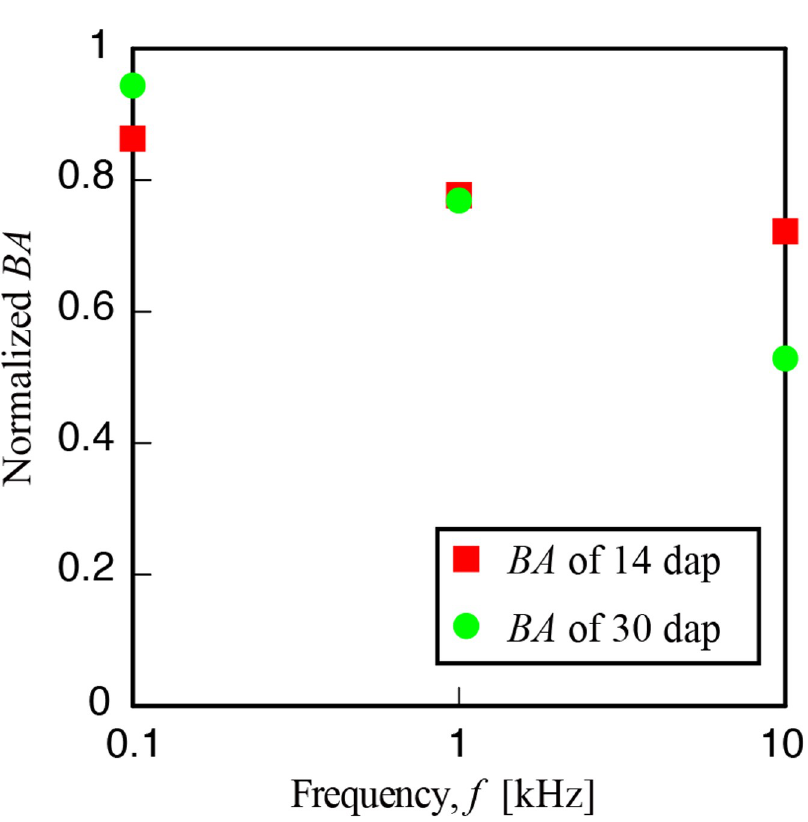
Fig 8. Normalized BA as a function of frequency for arugula plant at 14 days (red square) and 30 days (green circle). Only the result for 10kHz is statistically significant.